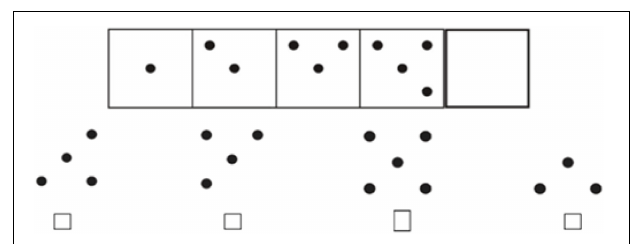
FIGURE 3 | Graphic sequence inference